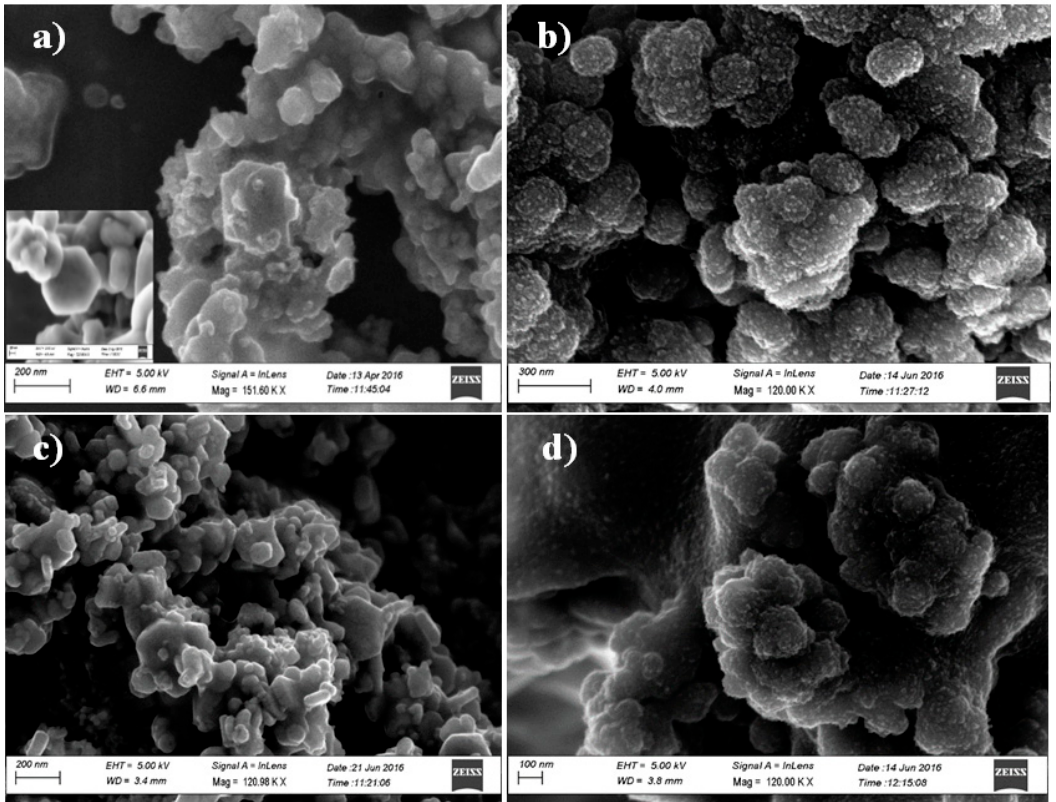
Figure 10. FESEM images of samples calcined at 550 °C: a ) Fe 3 O 4 /1.5CeO 2 ; b ) Fe 3 O 4 :CITR/1.5CeO 2 ; c ) / 1.5CeO / 1.5CeO Fe 3 O 4 :PVP/1.5CeO 2 ; d ) Fe 3 O 4 :OA/1.5CeO 2 . ( c ) Fe 3 O 4 :PVP 2 ; ( d ) Fe 3 O 4 :OA 2